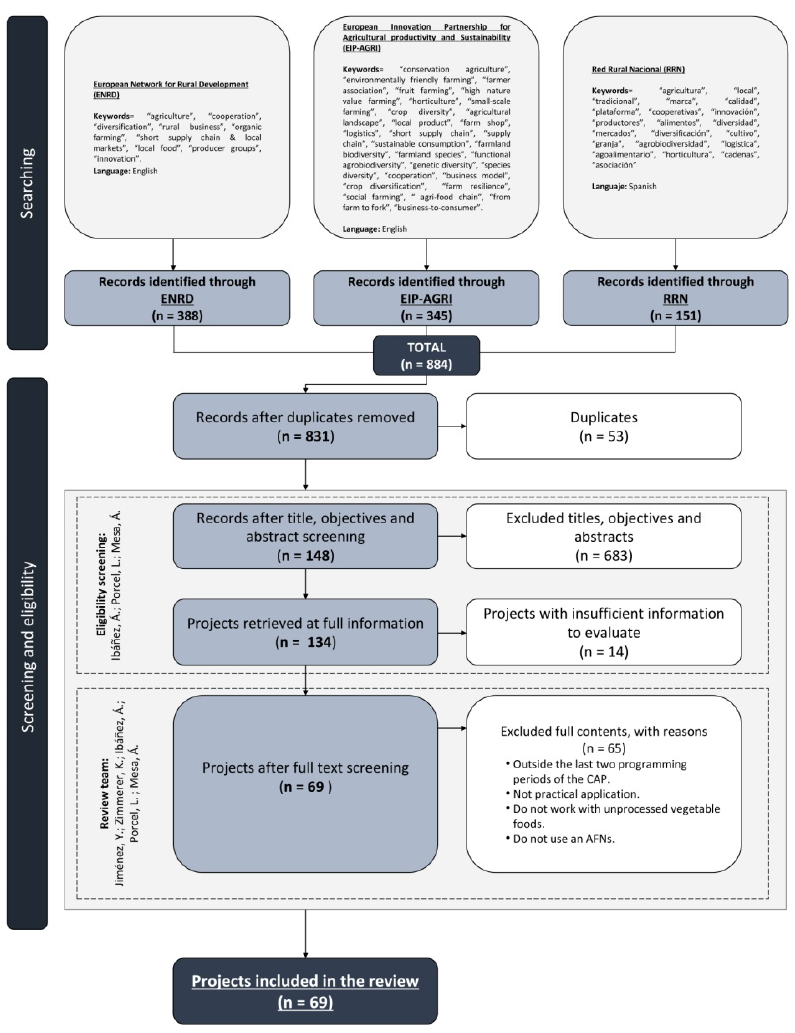
Figure 1. Methodological procedure: flow chart describing the selection and review process.